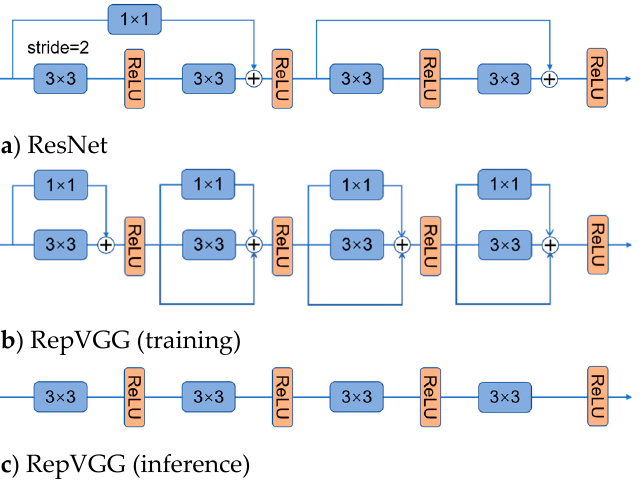
Figure 3. Sketch of RepVGG architecture. ( a ) The body of ResNet. ( b ) The body of the training time RepVGG. ( c ) The body of the inference time RepVGG. Only stage 2 of RepVGG-B1g4 is shown, which has 4 layers and conducts downsampling via stride-2 convolution at the beginning.